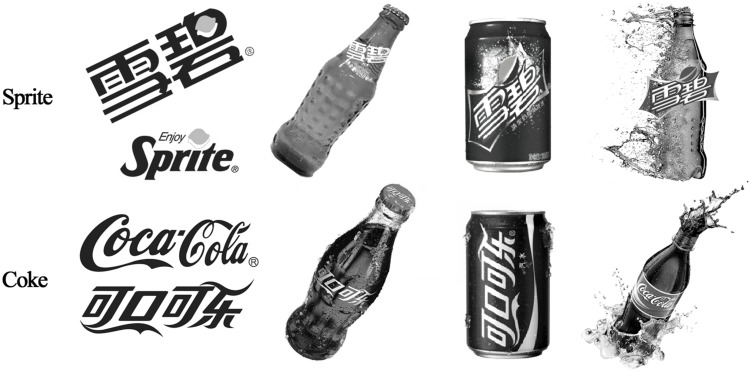
Target exemplars in Study 3.